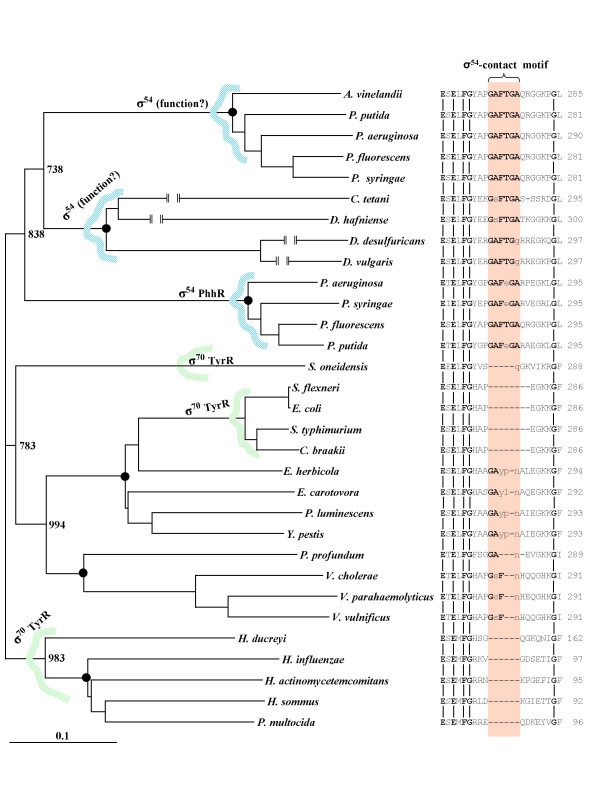
Protein tree of TyrR homologs. Nodes supported by bootstrap values of 998 or more are marked with solid circles, and the bootstrap values for nodes internal to these are shown. Generic names relevant to the organism abbreviations can be viewed in Fig. 8. A conserved region containing the σ54 contact motif GAFTGA is highlighted as an orange band. "Imperfect" residues in this region are shown in lower-case fonts. Residue numbers are shown at the right. TyrR and PhhR are regulators of σ70 and σ54 promoters, respectively. Four σ54 proteins of unknown function have very long branches, and to facilitate the visual presentation, the gaps in branch continuity shown represent a scale-bar distance of 0.1. Clades possessing σ54 regulators are indicated with blue stripes, and σ70 regulators are indicated with green stripes.